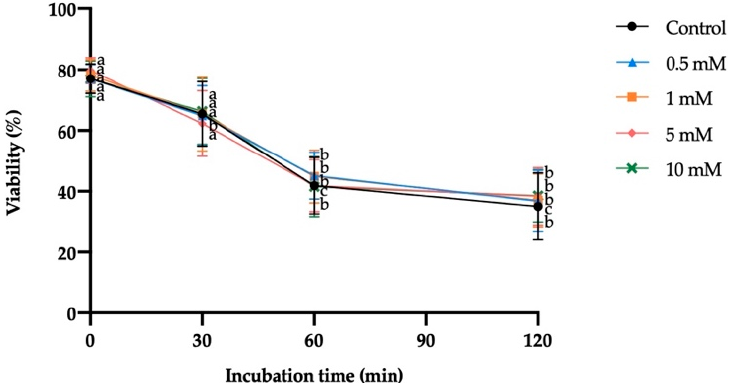
Figure 5. Mean ± SEM of viability of donkey sperm exposed to oxidative stress with different hydrogen peroxide (H 2 O 2 ) concentrations measured at different incubation times. No significant differences were found between H 2 O 2 concentrations within a given incubation time. (a,b) Different letters indicate significant differences ( p ≤ 0.05) between incubation times within a given H 2 O 2